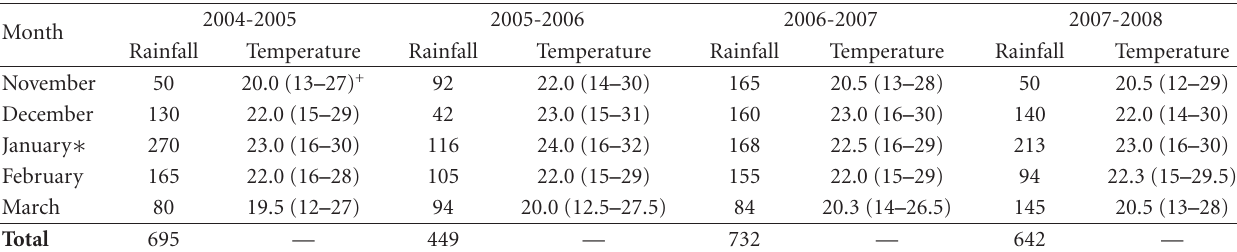
Table 2: Monthly rainfall and air temperatures registered in the di ff erent field assays.